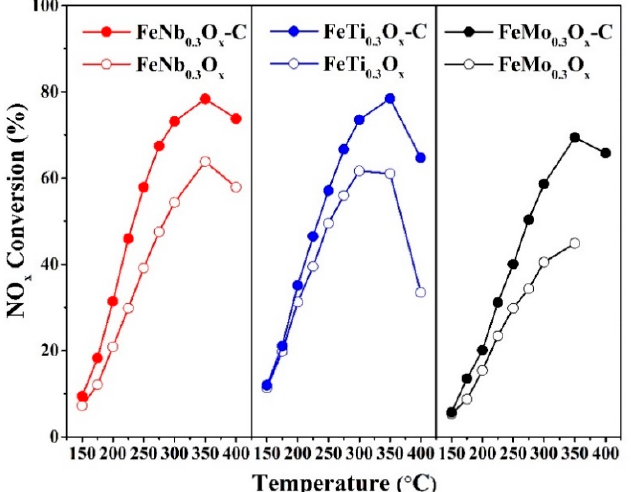
Figure 1. NO x conversion over all the FeM 0.3 O x -C and FeM 0.3 O x (M = Nb, Ti, Mo) samples. Reaction